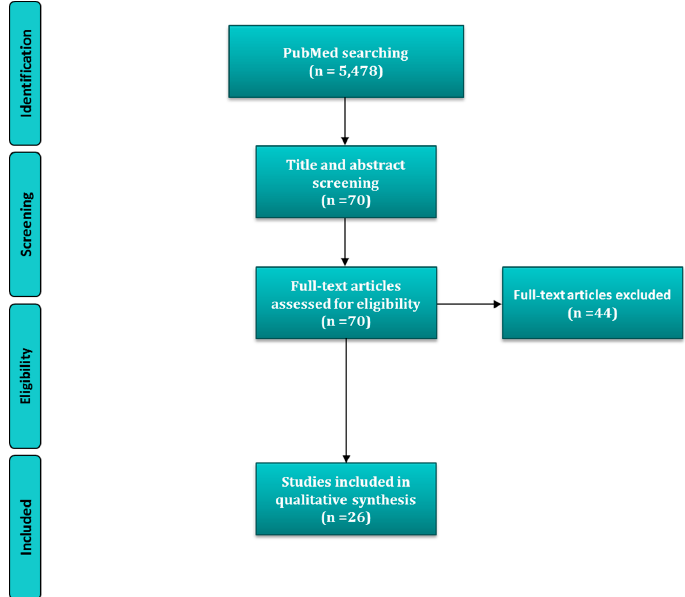
Figure 1. Flow diagram and search strategy.